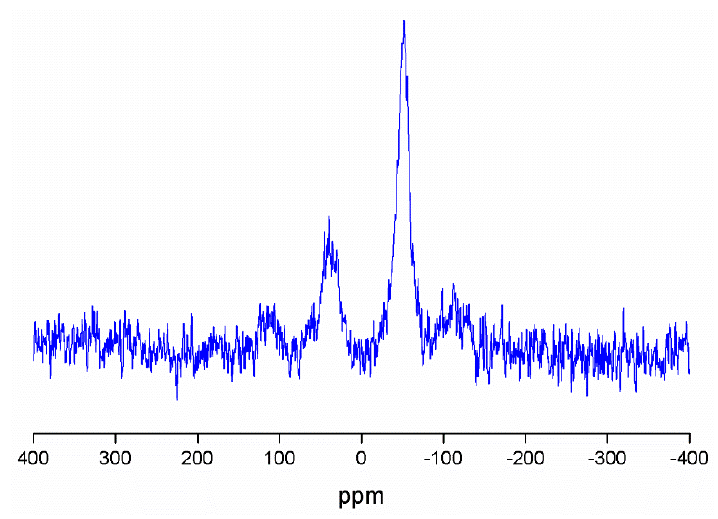
Figure 2. 119 Sn MAS NMR spectrum of MSN-AP-FA-Sn.